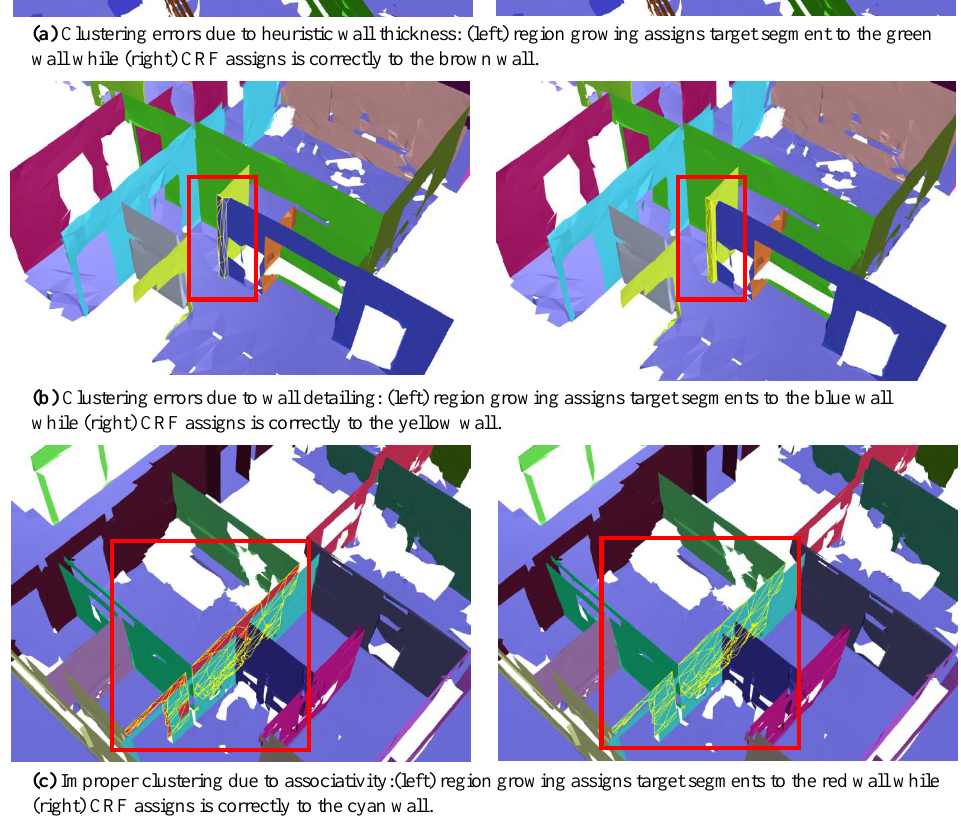
Figure 8. Overview of the difference in clustering between conventional region growing and the proposed CRF method.